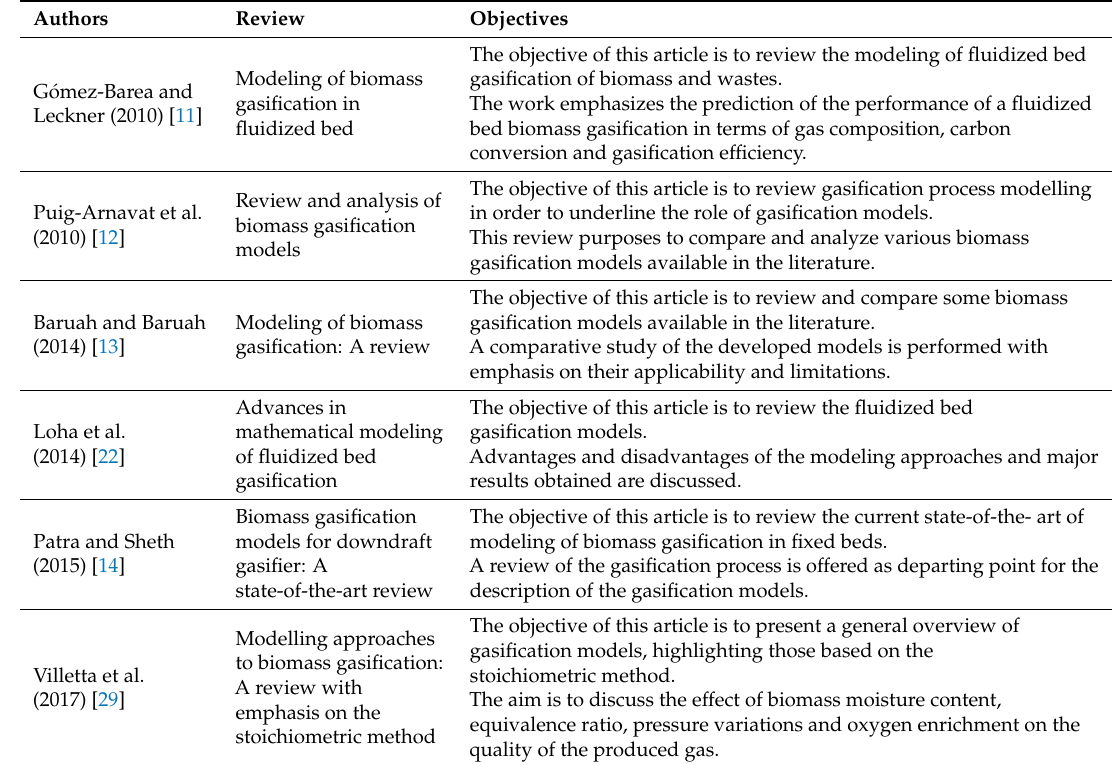
Table 1. Summary of existing reviews on biomass gasification